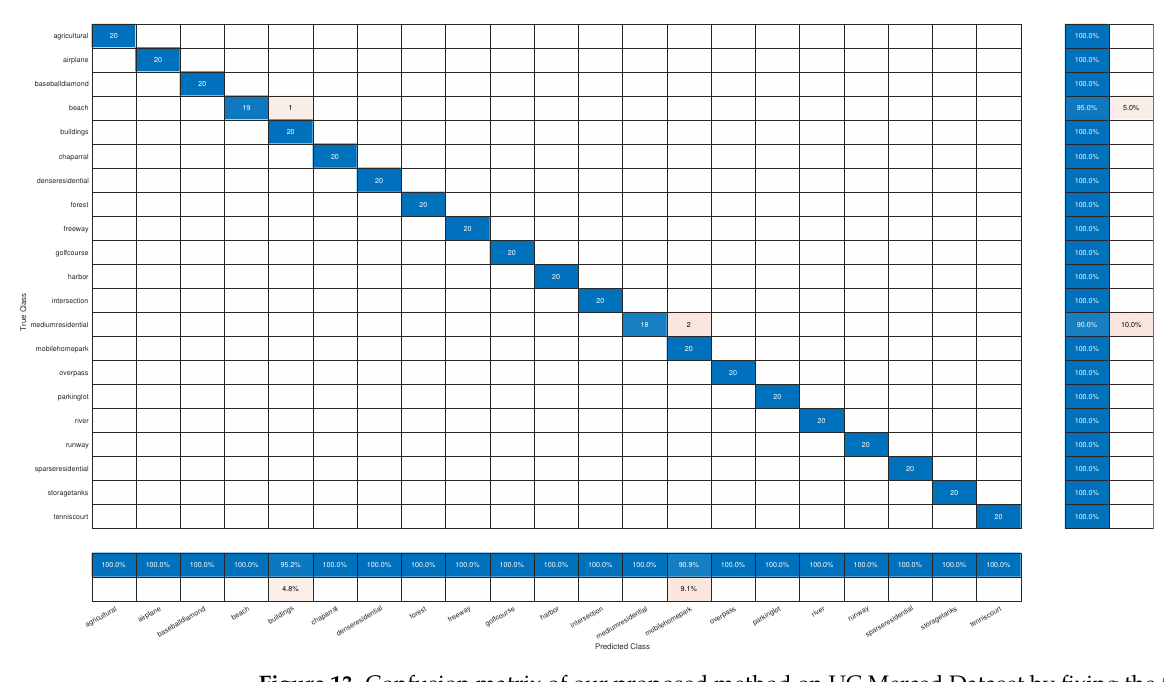
Figure 13. Confusion matrix of our proposed method on UC Merced Dataset by fixing the training ratio as 80%. Zoom in for a better view.